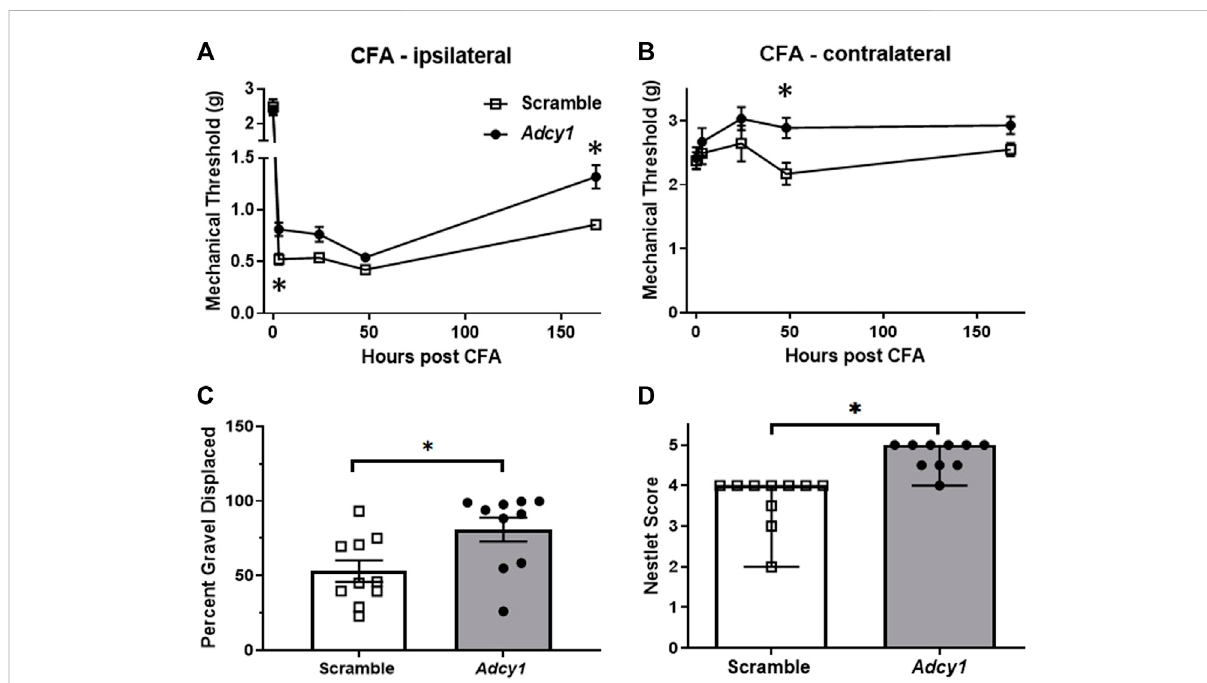
FIGURE 5 Intrathecal delivery of AAV9-Adcy1-shRNA reduces mechanical hypersensitivity following intraplantar CFA. Mechanical paw withdrawal thresholds were measured before and after a unilateral hind paw injection of 20 µl CFA. (A) AAV9- Adcy1 ( C ) mice had signi fi cantly higher MPW thresholds than AAV9-scramble mice ( □ ) on the injected paw (repeated measures ANOVA with Bonferroni ’ s post hoc test, F (1, 18) = 6.157, p = 0.0232), (B) andontheCFAuninjectedpaw(repeatedmeasuresANOVAwithBonferroni ’ s posthoc test,F(1,18)=9.148, p =0.0073). (C) AAV9- Adcy1 micehaveincreasedburrowing(unpaired t -test, p =0.0188) (D)